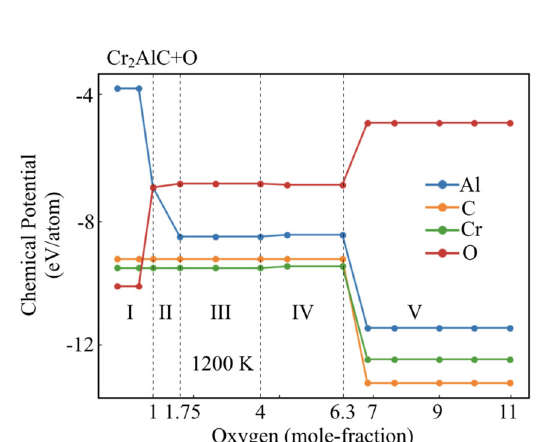
Fig. 10 Chemical activity of elements during oxidation process. Oxidation reaction chain showing change in chemical potential of Cr 2 AlC as a function of changing molar percent oxygen at 1200 K. On oxidation, the partial chemical potentials of Cr/Al/C reduce while the chemical potential of invading O 2 increases (see Supplementary Fig. 3).